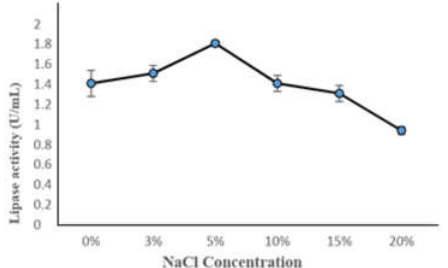
Fig. 5. The effect of NaCl concentration on lipase activity producing by AR11 in a medium with (pH 9). Results represent the means of three separate experiments, and indicate standard